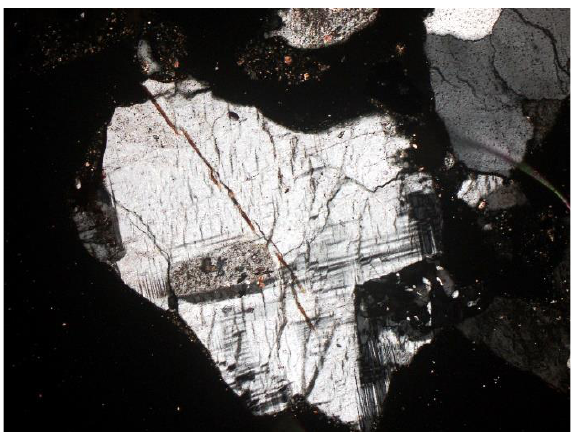
Figure 11. Microcline (K-feldspar) with visible twinning in two directions. SP3 sample, thin section, 2P, 200×, transmitted light.